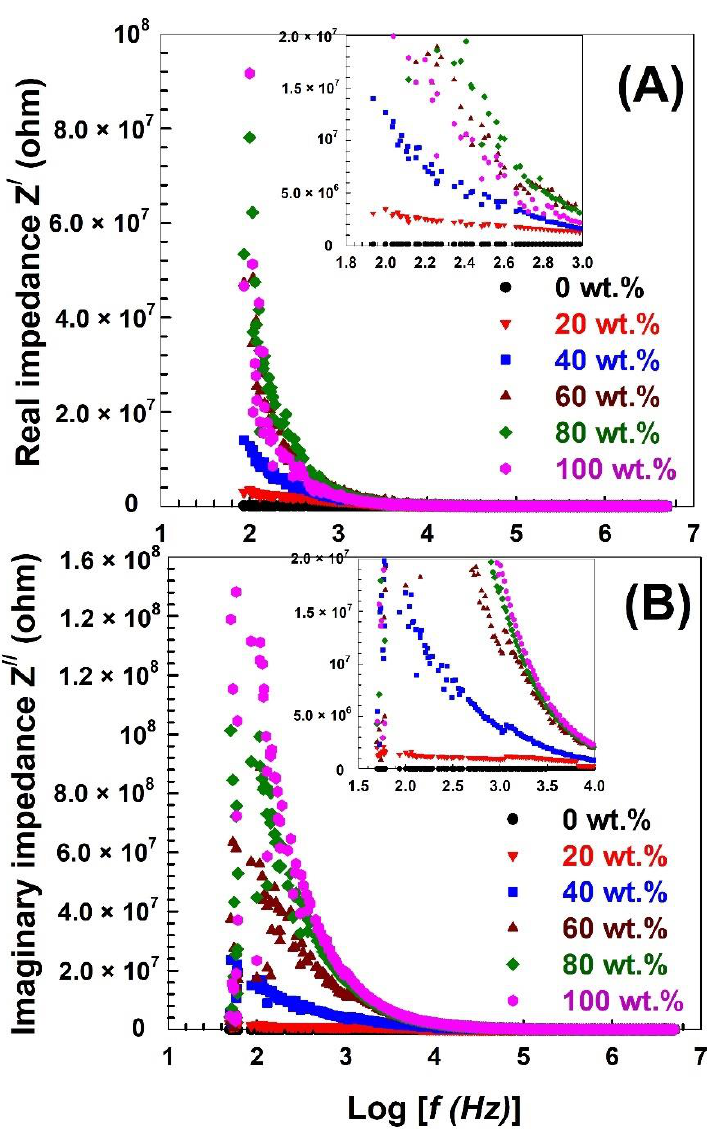
Figure 6. Frequency dependence of ( A ) real impedance Z / and ( B ) imaginary impedance Z // .